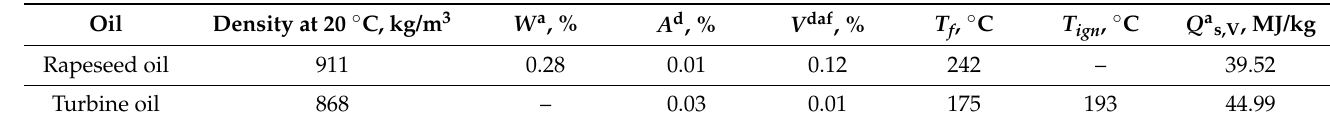
Table 3. Characteristics of oils